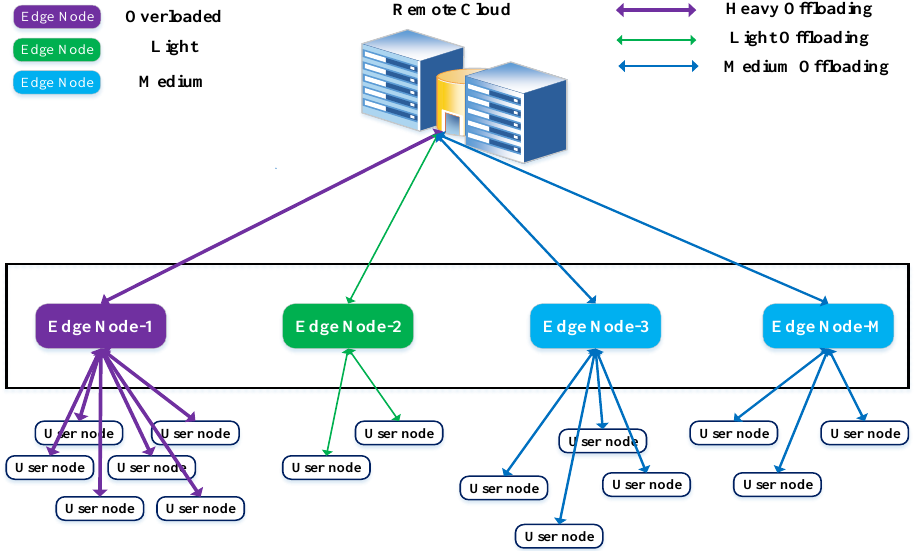
Figure 1. The overloaded problem in a multi-user MEC